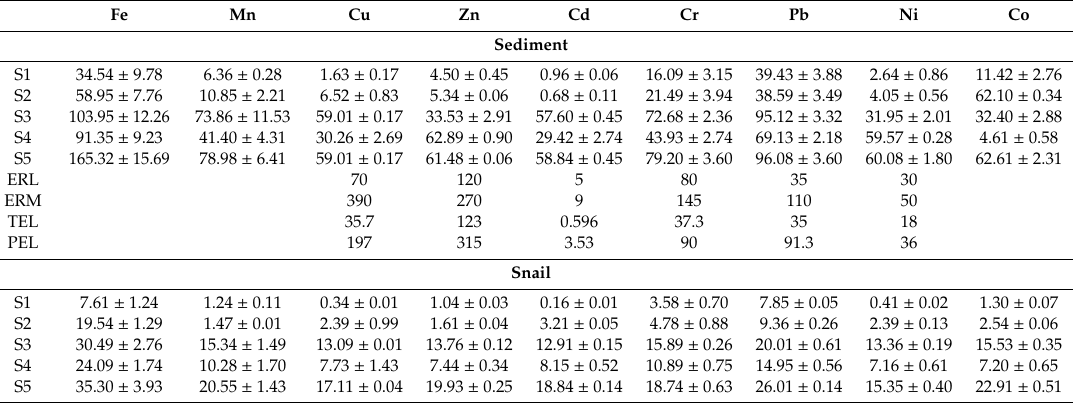
Table 1. Mean concentrations of metals in sediment and freshwater mollusk.